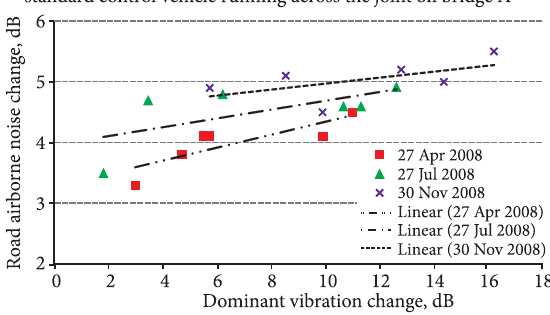
Fig. 11. Road airborne noise change and vibration change on bridge surface (using Direct Sound and Vibration Measurement Methodology)